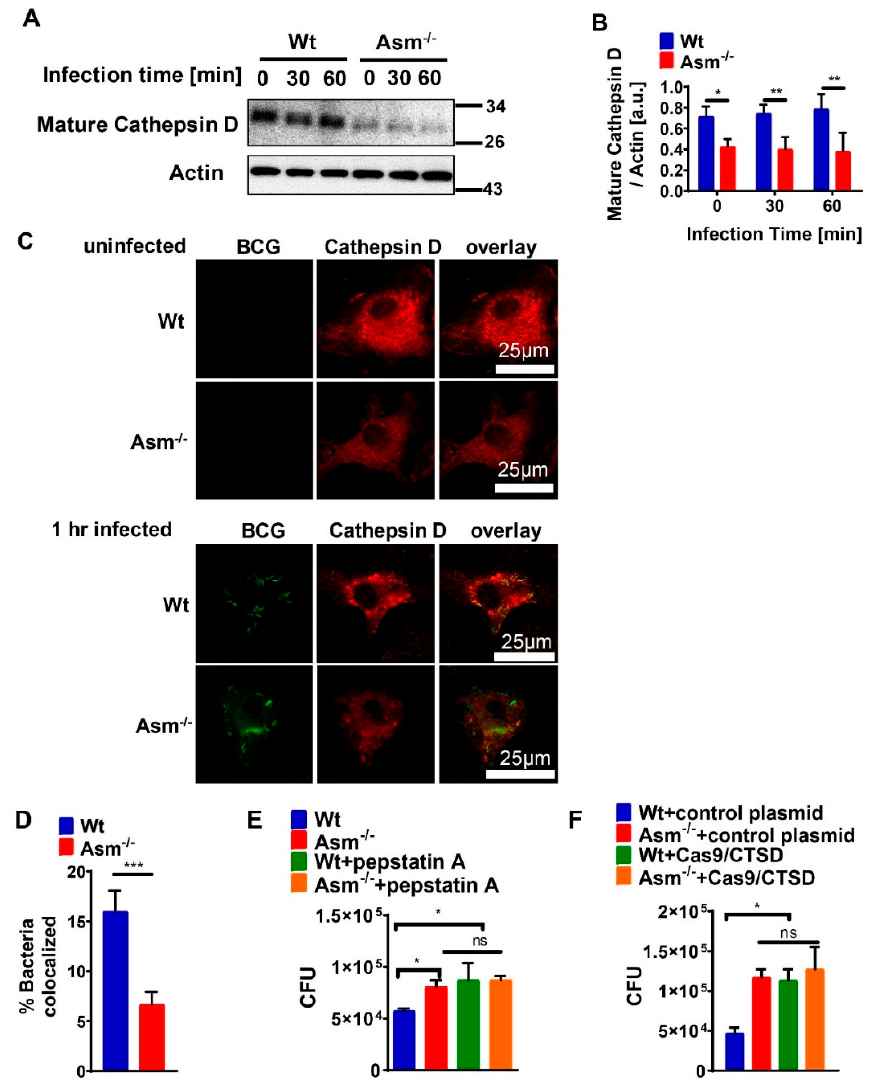
Figure 3. Acid sphingomyelinase determines expression of cathepsin D, which is essential for BCG degradation. ( A ) Bone-marrow-derived macrophages (BMDMs) from wild-type (wt) and Asm-deficient (Asm − / − ) mice were infected with BCG for the indicated times or left uninfected and then subjected to Western blot analysis using antibodies against mature cathepsin D (CTSD) and β -actin. Western blot is representative of 3 independent experiments. ( B ) Expression of CTSD was normalized to actin levels and displayed as arbitrary units (a.u.) by using ImageJ. Shown are means ± SD of 3 experiments; p -values were calculated by ANOVA followed by Bonferroni’s multiple comparisons test, ** p < 0.01, * p < 0.05. ( C ) Wt or Asm-deficient macrophages were left uninfected or infected with GFP-BCG for 60 min, fixed, and stained with Cy3-labeled antibodies against CTSD. Samples were analyzed by confocal microscopy. Picture represents 3 independent studies. Scale bar = 25 µ m. ( D ) Co-localization of GFP-BCG and CTSD was measured from at least 50 bacteria / sample and shown as mean ± SD of 3 experiments. *** p < 0.001 (Student’s t -test). ( E ) BMDMs were left untreated or pretreated with 10 µ M pepstatin for 1 h and infected with BCG for 24 h. Number of BCG CFUs was determined after 2 weeks of culture. Shown are means ± SD of the CFU from 3 experiments; two-way ANOVA followed by Bonferroni’s multiple comparisons test, * p < 0.05. ( F ) BMDMs were transfected with either CTSD gRNA / CRISPR-cas9 plasmid or CRISPR-cas9 control plasmid, then infected with BCG for 24 h for CFU assay. Shown are means ± SD of CFU of 3 independent experiments. Quantitative analysis was performed with GraphPad and analyzed with two-way ANOVA followed by Bonferroni’s multiple comparisons test, * p < 0.05. ns = no significant.